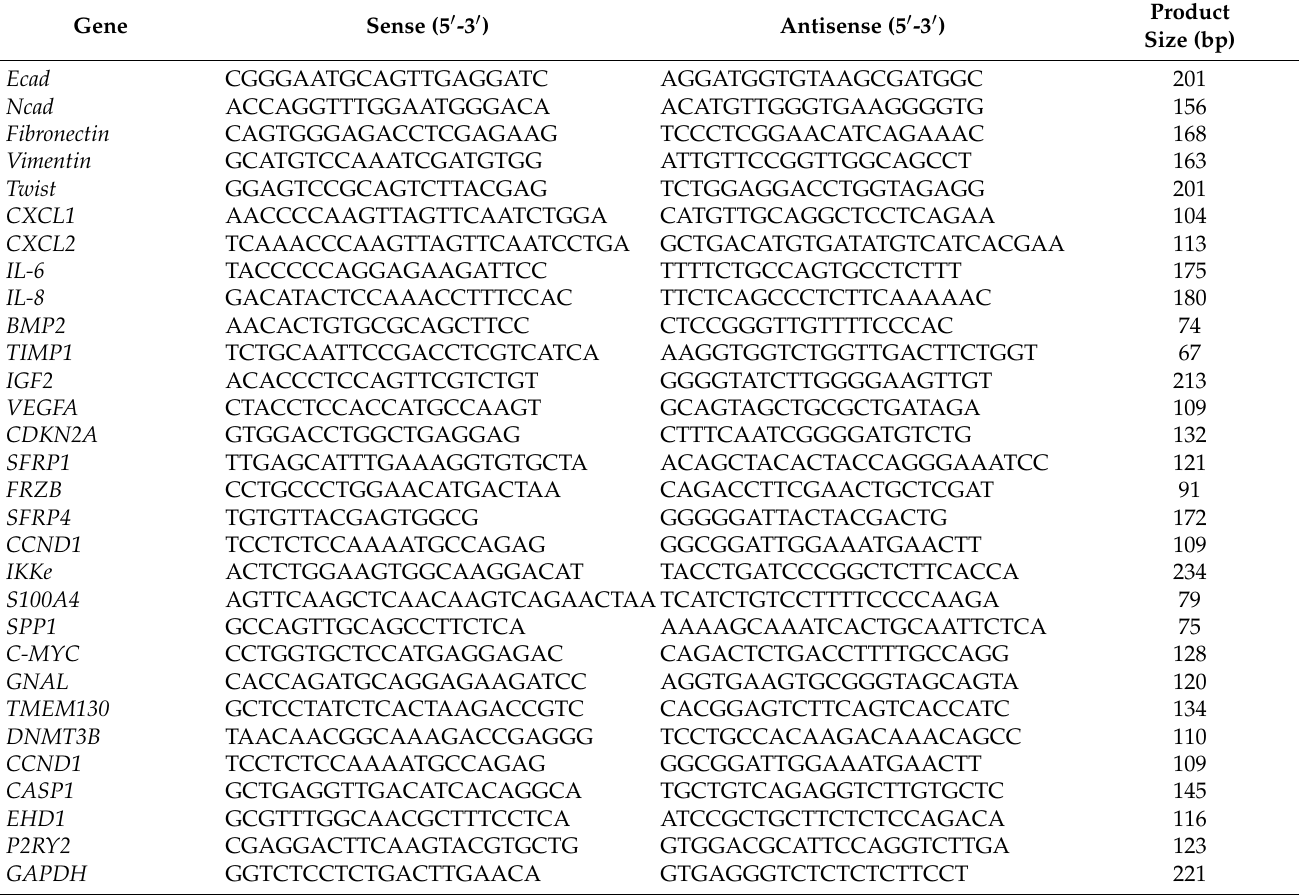
Table 5. Sequences of the primers used in this